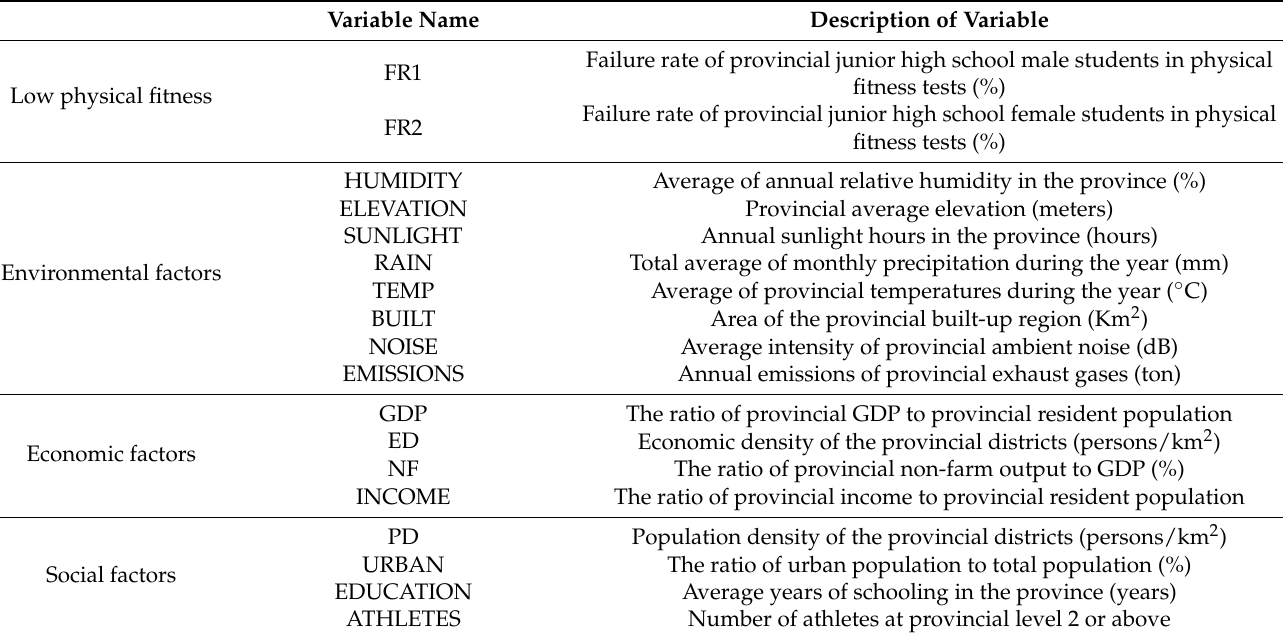
Table 1. A full list of dependent and independent